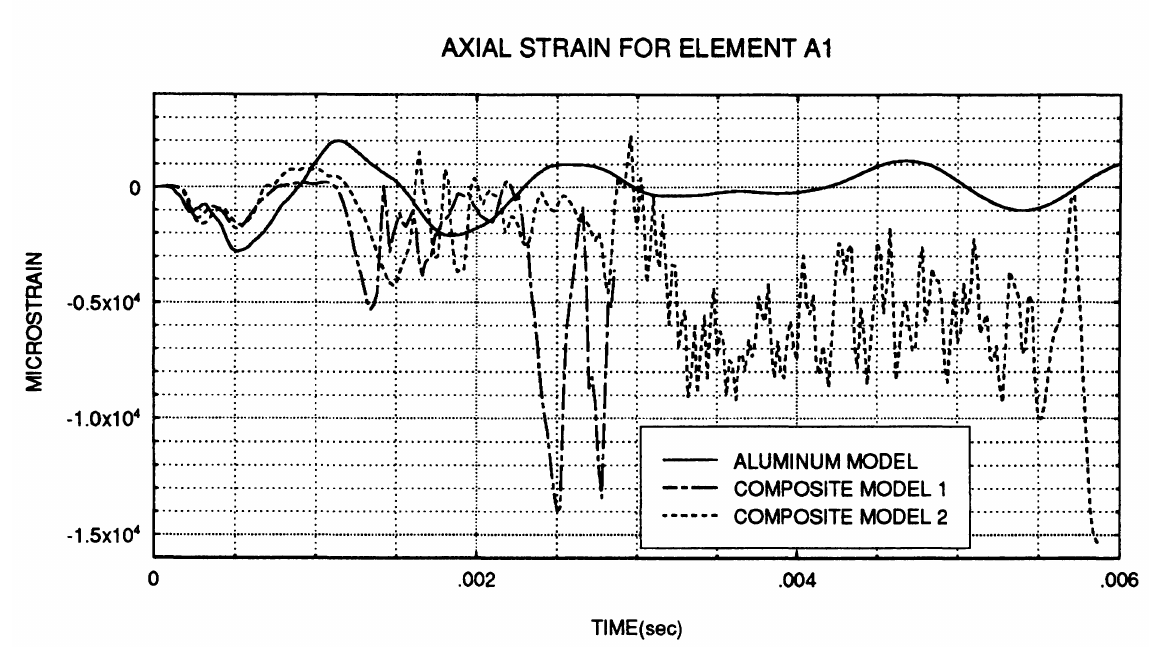
FIGURE 4 Axial strain at position Al for uncoated and coated aluminum